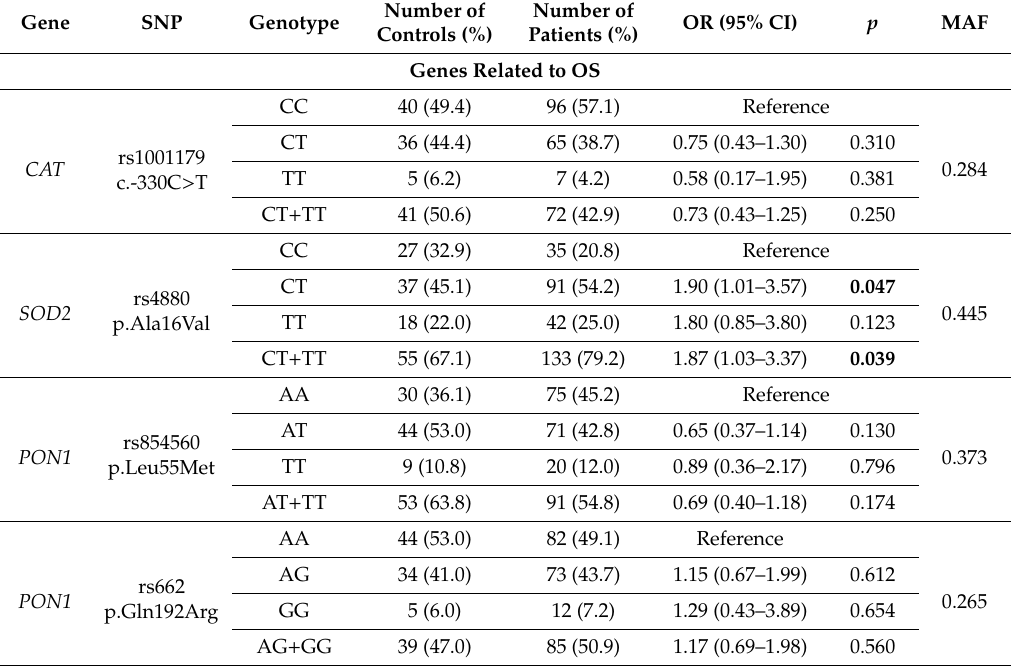
Table 2. The frequencies of investigated polymorphisms in PCOS patients and